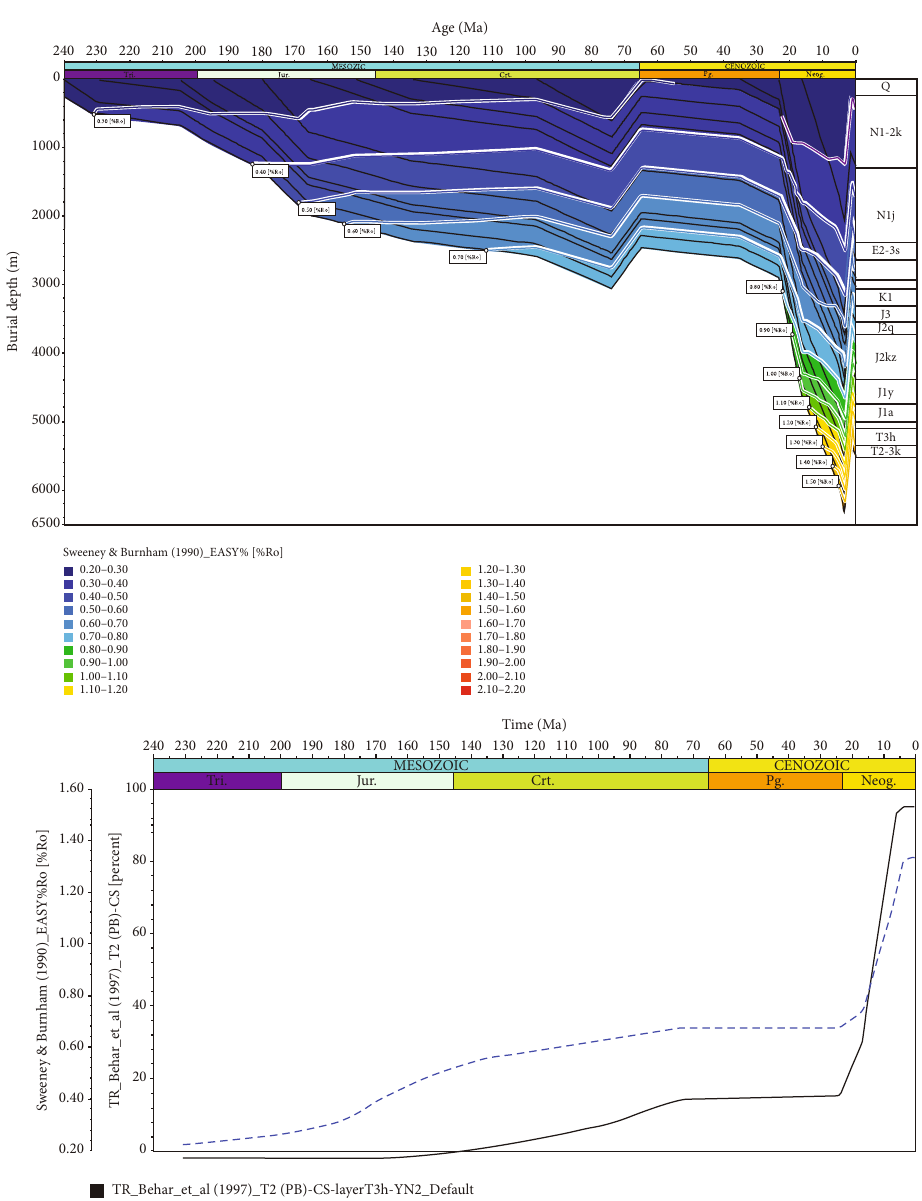
Figure 6: The burial history and Ro evolution of the Yinan-2